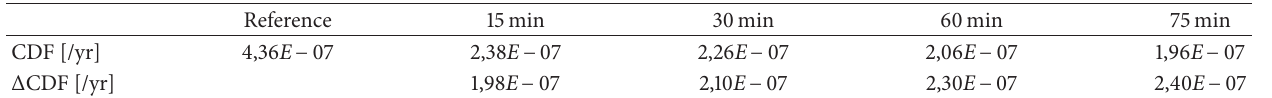
Table 8: CDF of analyzed case scenarios.